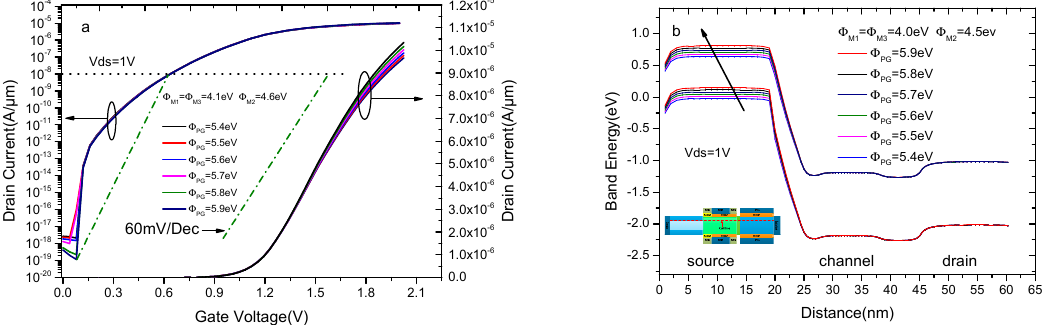
Figure 7. ( a ) Simulated log scale and linear scale transfer characteristics of DMMG-HJLTFET with different polar gate work function( Φ PG ); ( b ) the variation of energy band with different polar gate work function( Φ PG ).